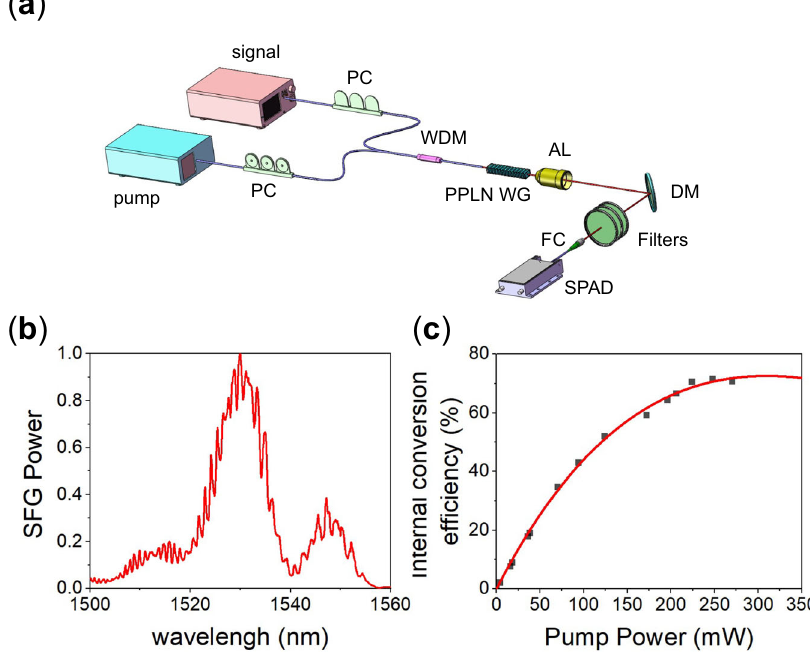
Fig. 2 Frequency conversion performance of the chip. a Experimental setup. PC polarization controller, WDM wavelength division multiplexer, WG waveguide, AL aspherical lens, DM dichroic mirror, Filters including a longpass fi lter, a shortpass fi lter, two bandpass fi lters, and an etalon, FC fi ber coupler, SPAD silicon single-photon avalanche photodiode. b SFG tuning curve. c measured SFG conversion ef fi ciency versus pump power (solid square), and the sin 2 () fi tting